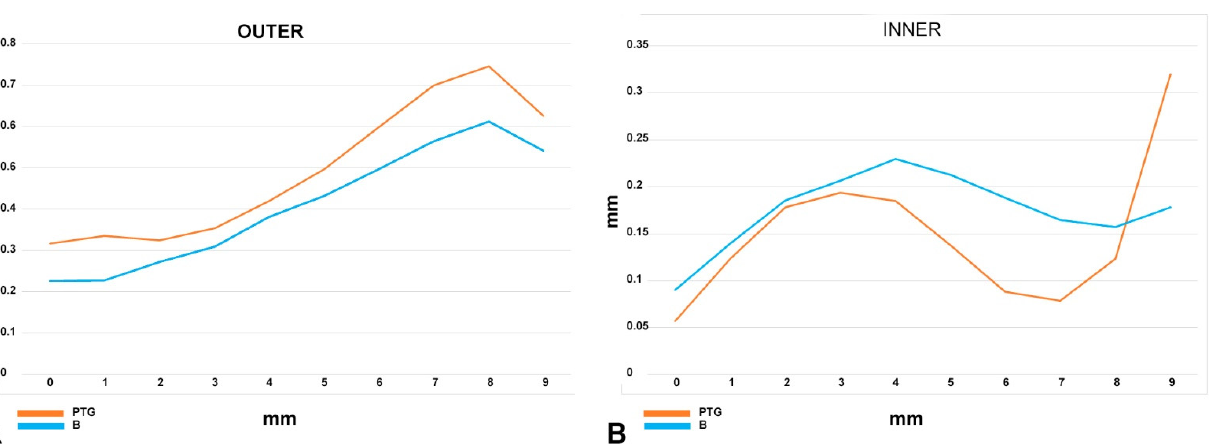
Figure 3. Behavior of the systems outside ( A ) and inside ( B ) of the curve. Table 2. Amounts of resin removed per system. Table 1. Descriptive statistics by instrumentation system and